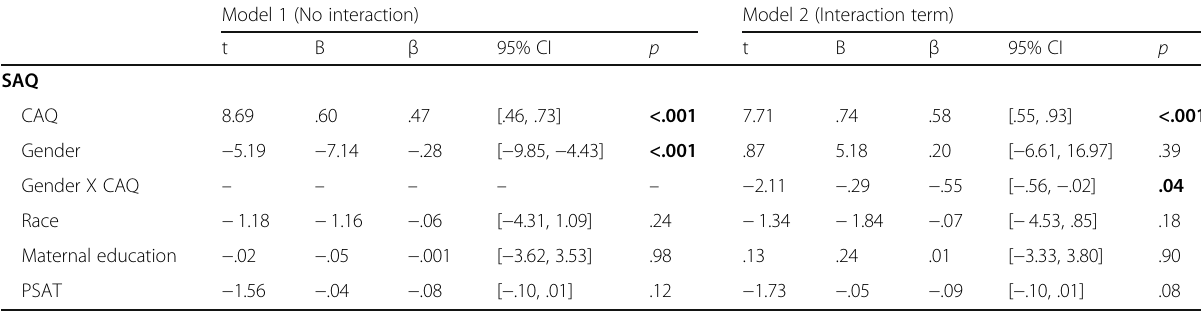
Table 2 Linear regression models predicting adolescent spatial activities Model 1 (No